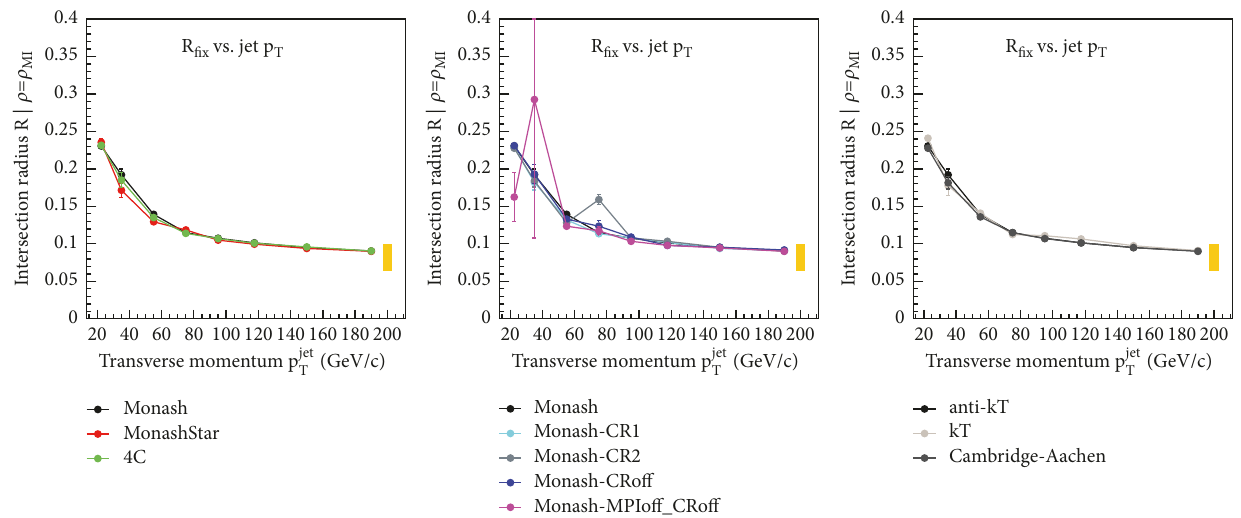
Figure 7: Evolution of the intersection radius 𝑅 with the jet momentum 𝑝 jet , compared for several PYTHIA tunes (left) , different settings fix T (center) , and different jet reconstruction algorithms in the case of the Monash tune (right) . The range indicated with the shaded band is the absolute uncertainty arising from the choice of bin width (see text for details).